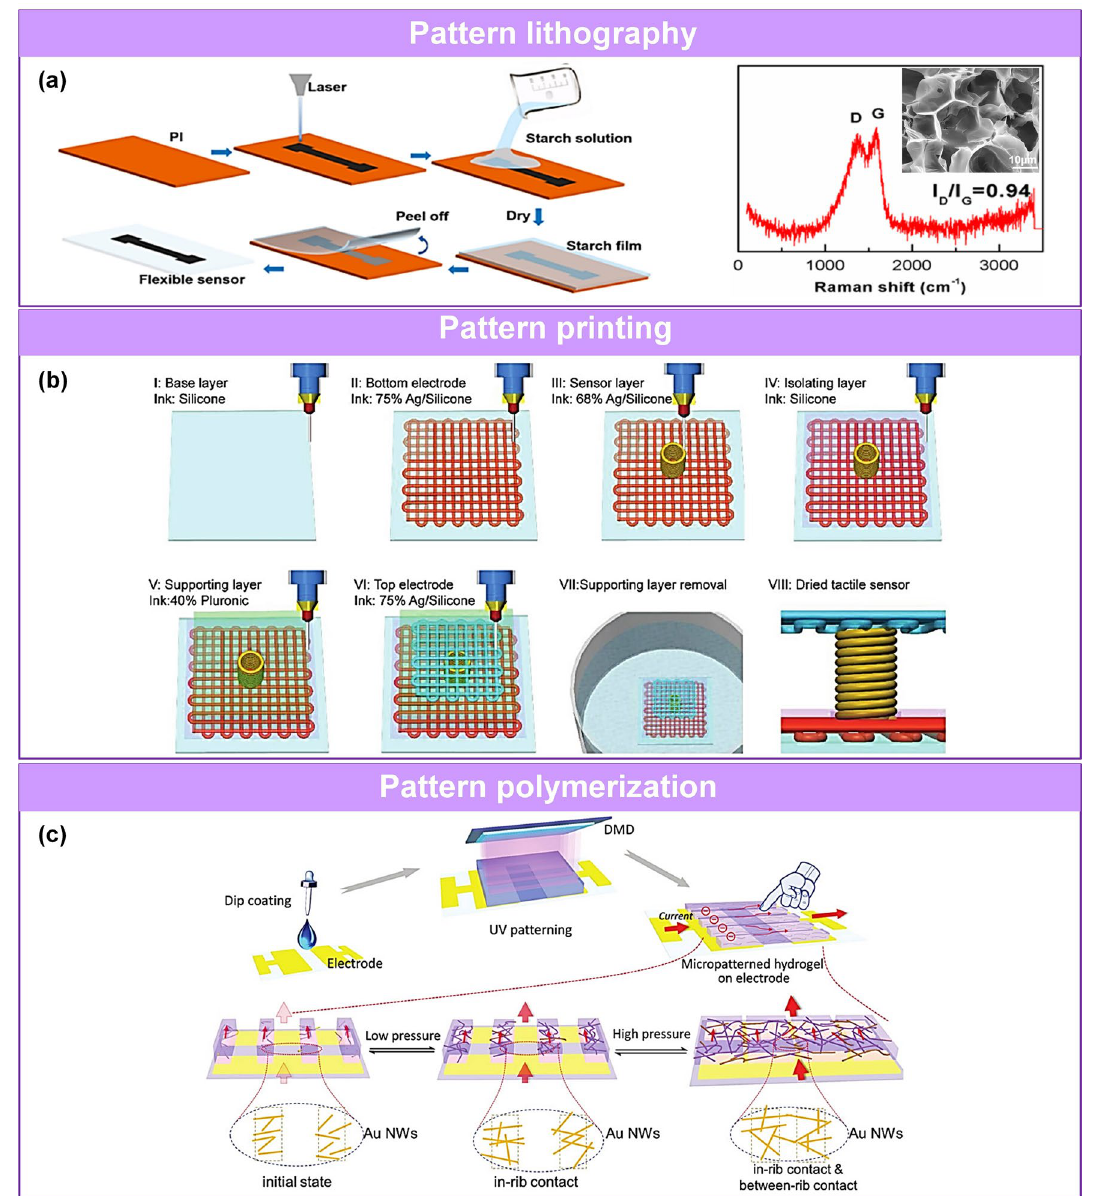
Fig. 14 Patterned synthesis of structured sensing materials. a Construction process of sensor based on laser-treated PI film to starch film [115]. Copyright (2020) American Chemical Society. b The tactile sensors fabricated by pattern printing [116]. Copyright (2017) Wiley–VCH. c The patterning composite hydrogel based on photopolymerization of PAAm [117]. Copyright (2018)